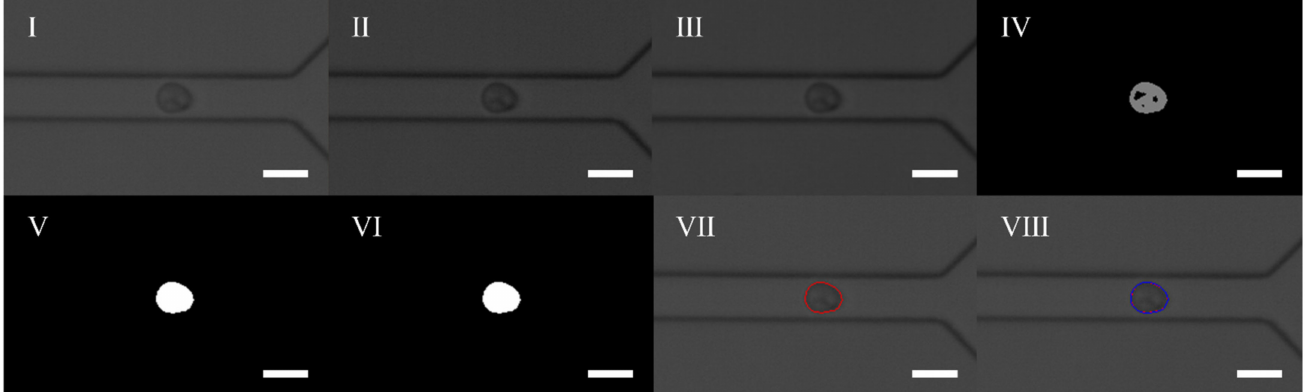
Figure 2. Image processing steps: ( I ). Defining ROI image; ( II ). Enhancing contrast ratio; ( III ). Filtering processing; ( IV ). The foreground image; ( V ). Filling the hole; ( VI ). Removing the noise points; ( VII ). The contour image; ( VIII ). The convex hull outline. The scale bar represents 25 µ m.